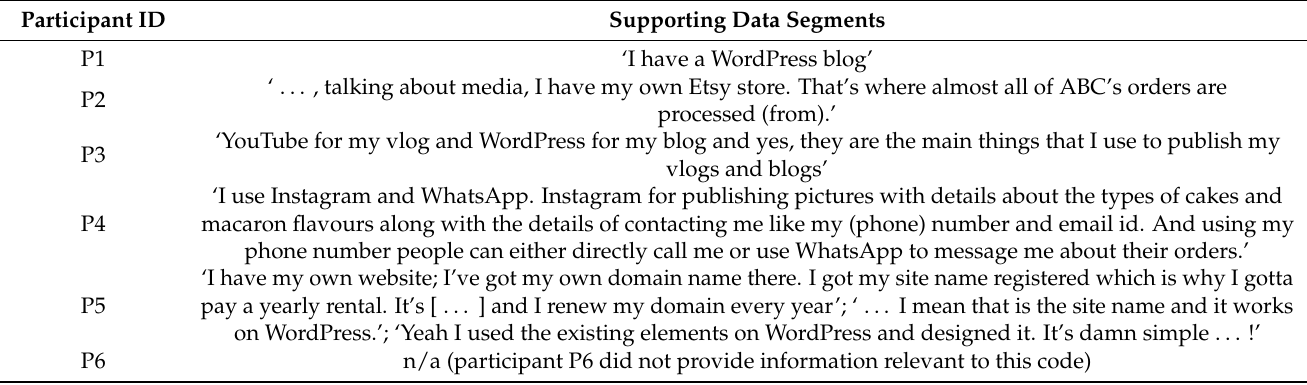
Table 1. Study 1: Descriptive code ‘Primary social media outlet